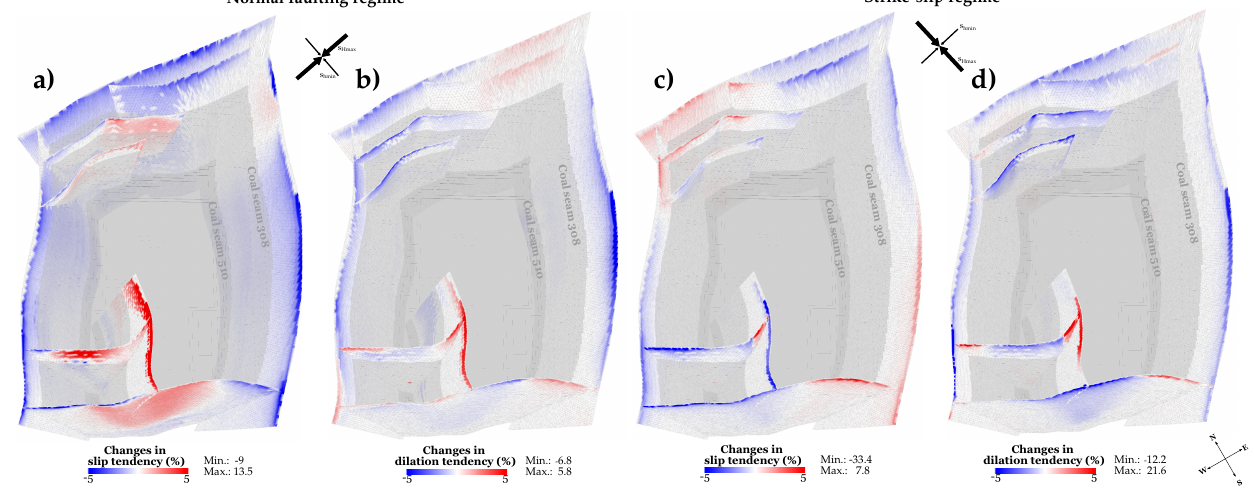
Figure 12. Simulated changes in ( a ) slip and ( b ) dilation tendencies at the operational state (1 year) for a normal faulting regime and a CO 2 storage within both coal seams. ( c ) Slip and ( d ) dilation tendencies for a strike-slip